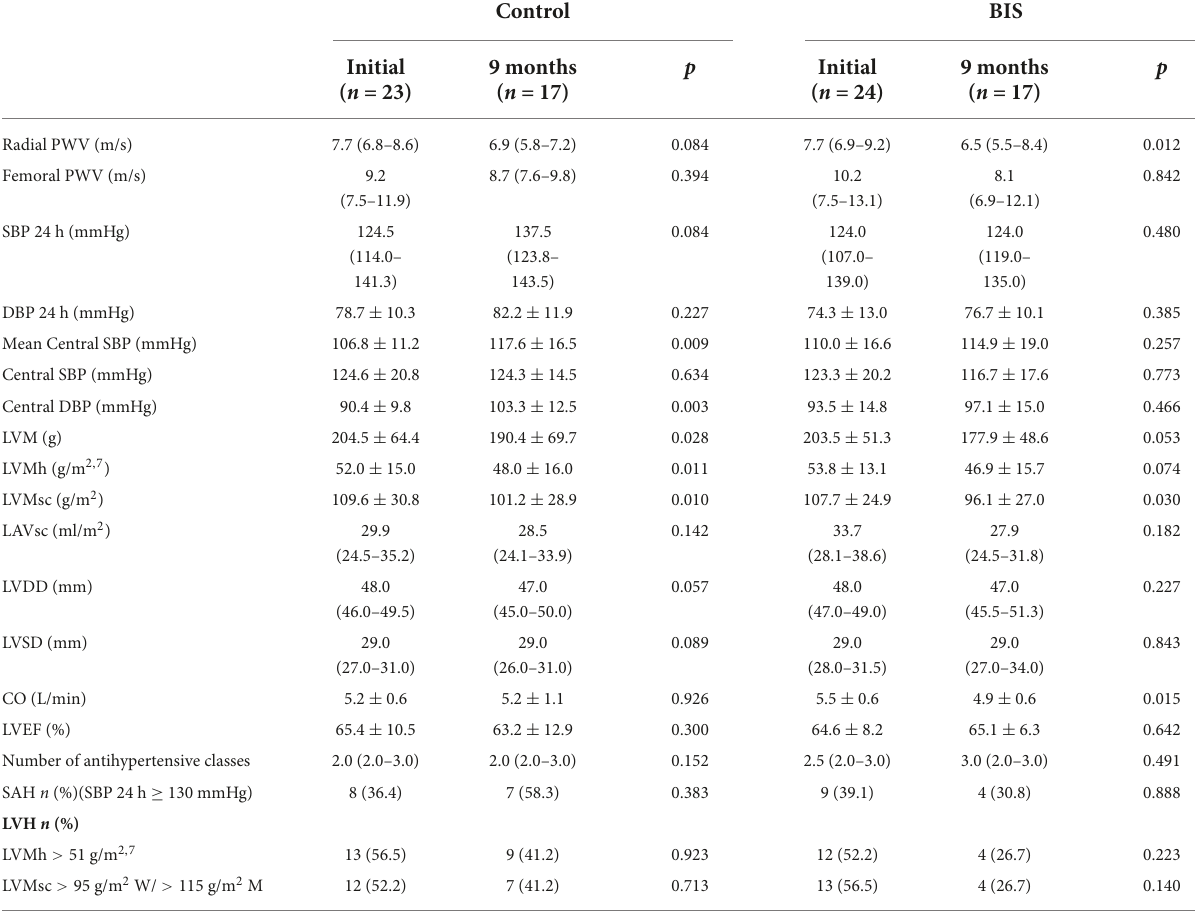
TABLE 4 Evolution of cardiovascular parameters and antihypertensive medication use at baseline and at 9 months in the study groups. Control